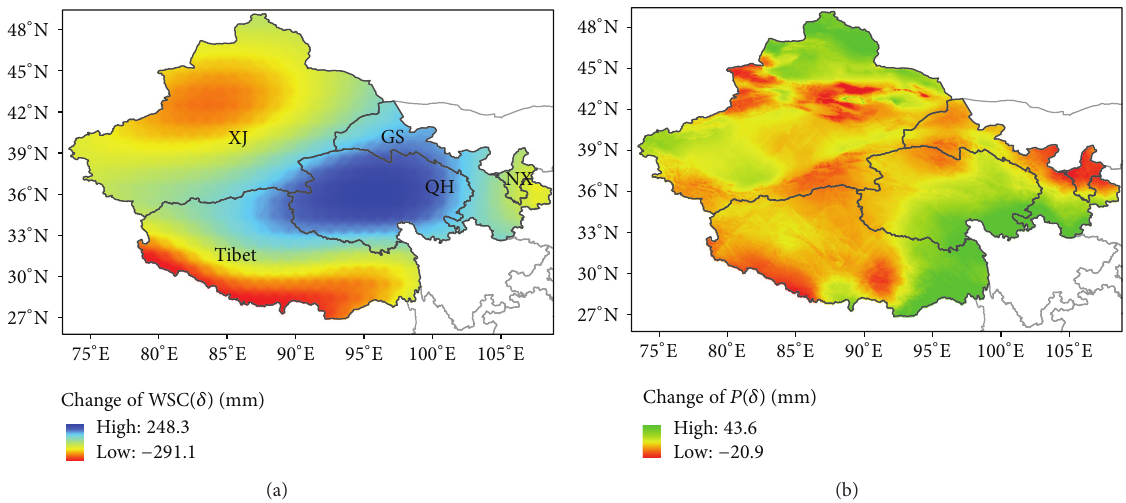
Figure 4: Temporal and spatial patterns of average annual WSC and precipitation over northwestern China from 2003 to 2010.